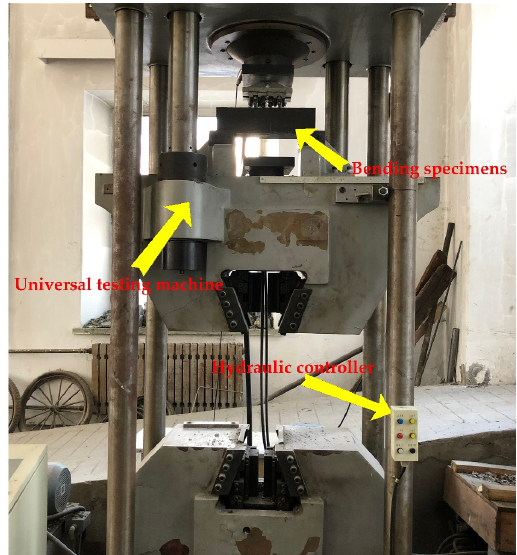
Figure 10. Universal testing machine.